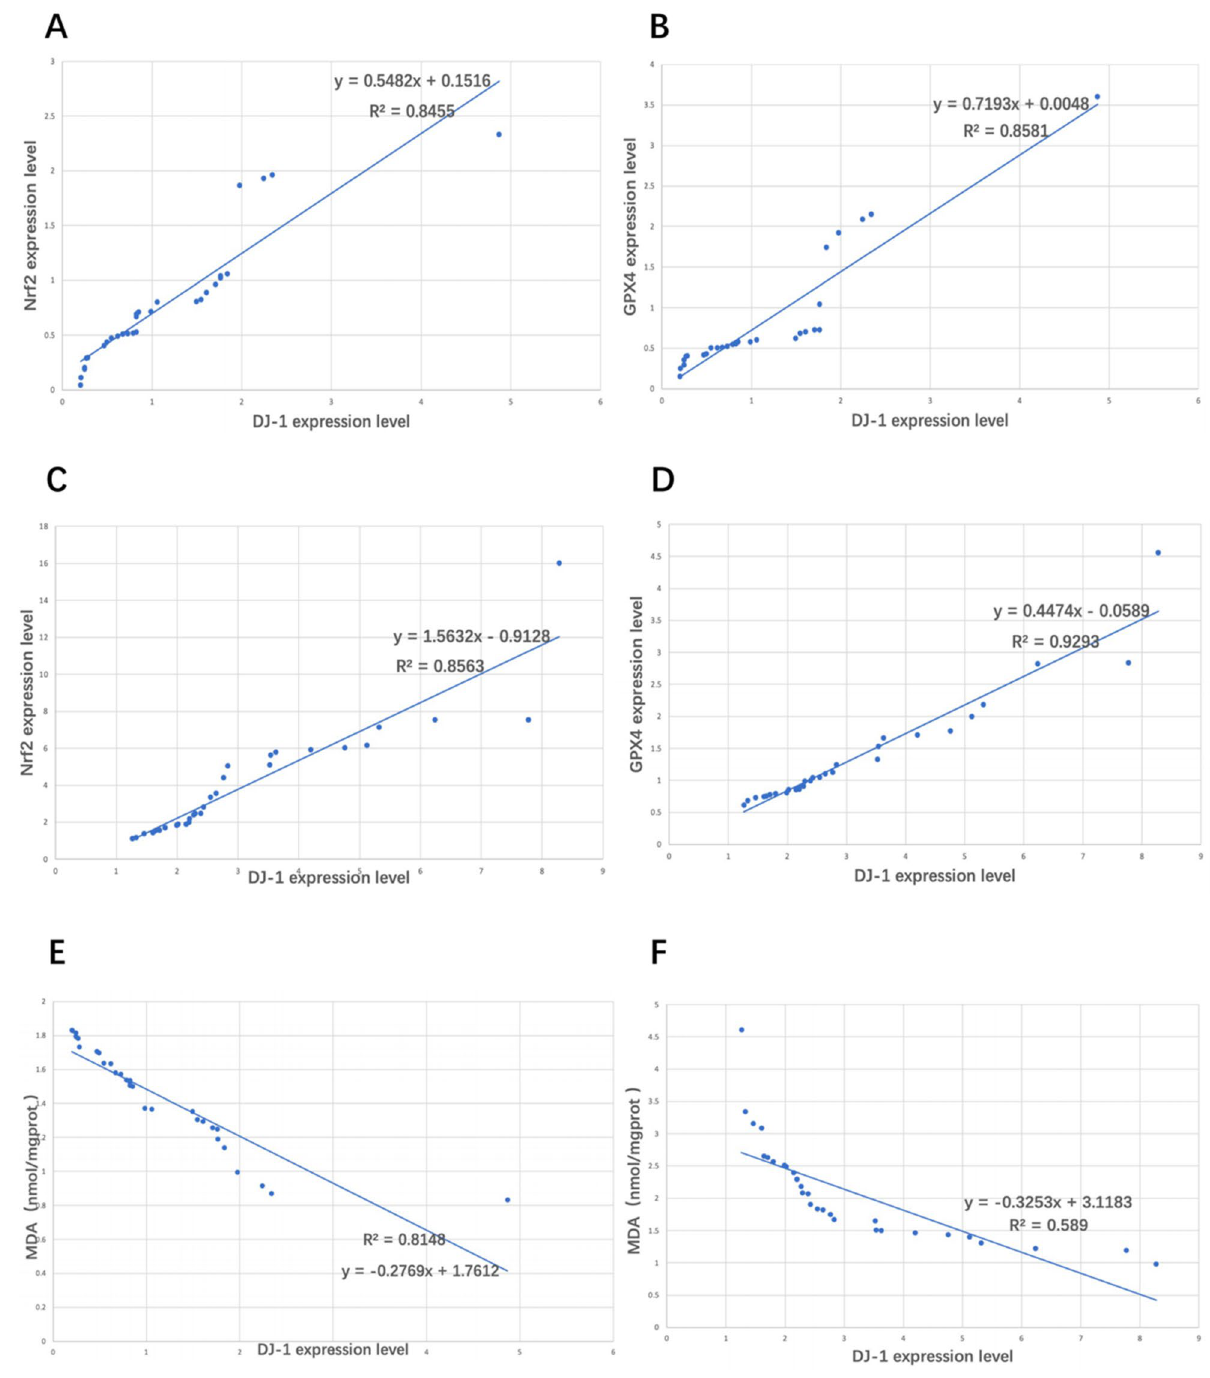
Figure 4. Correlations of DJ-1 protein expression levels with the Nrf2/GPX4 signaling pathway protein expression levels and MDA concentrations in each group. ( A , B , E ) The expression level of DJ-1 protein in the control group was positively correlated with the expression levels of the Nrf2/GPX4 signaling pathway protein, and negatively correlated with the concentrations of MDA (P < 0.001). ( C , D , F ) The expression level of DJ-1 protein in the PE group was positively correlated with the expression levels of the Nrf2/GPX4 signaling pathway protein, and negatively correlated with the concentrations of MDA (P <